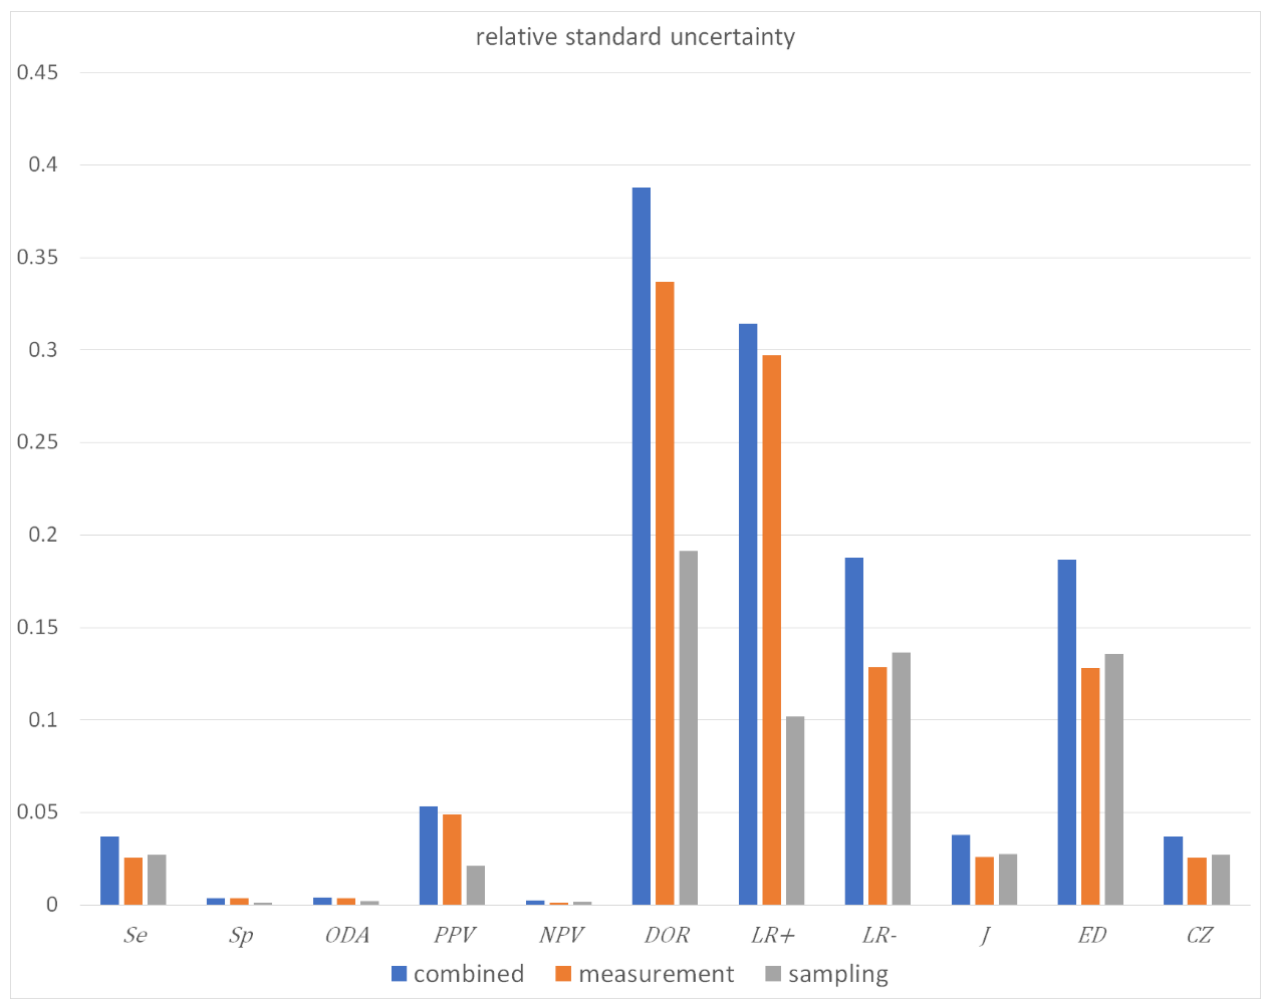
Figure 22. DAM relative standard uncertainties of diagnostic accuracy measures. Histogram of standard combined, meas- Figure 22. DAM confidence intervals versus population sample size plots. Plots of confidence intervals of ( a ) sensitivity urement and sampling uncertainties of diagnostic accuracy measures, with the respective parameter settings in Table 4. ( Se ), ( b ) specificity ( Sp ), ( c ) positive predictive value ( PPV ) and ( d ) negative predictive value ( NPV ) versus total population sample size ( n ) curves, with the respective parameter settings in Table